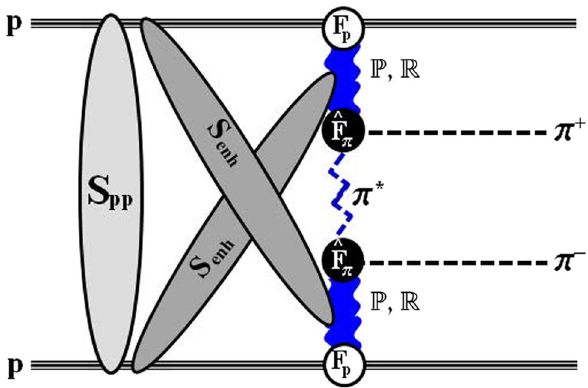
Fig. 1 Amplitude of the process of double pion LM CEDP p + p → p + π + + π − + p in the KMR approach [7–9]. The central part of the diagram is the Born amplitude (with Pomeron and two reggeons). A reggeized off-shell pion propagator is shown as a dashed zigzag line. Proton–proton rescattering is depicted as the S pp -blob, and “enhanced” corrections are also shown as the S enh -blob. The off-shell pion form factor is presented as a black circle